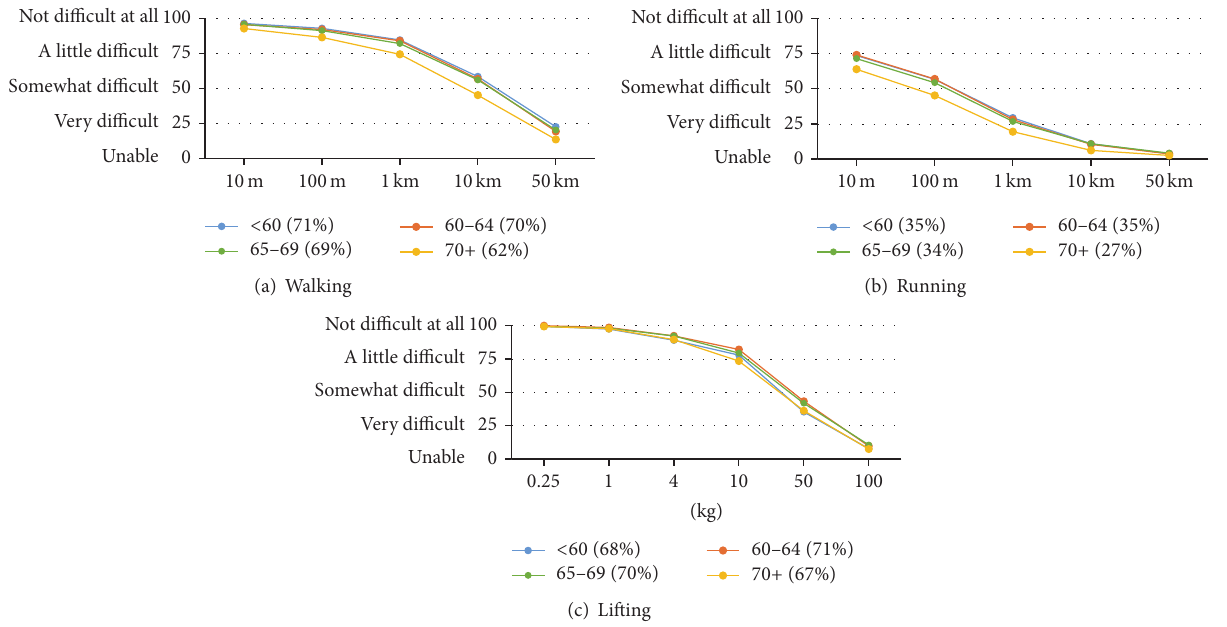
Figure 3: Mean walking, running, and lifting ability curves and summary scores by age